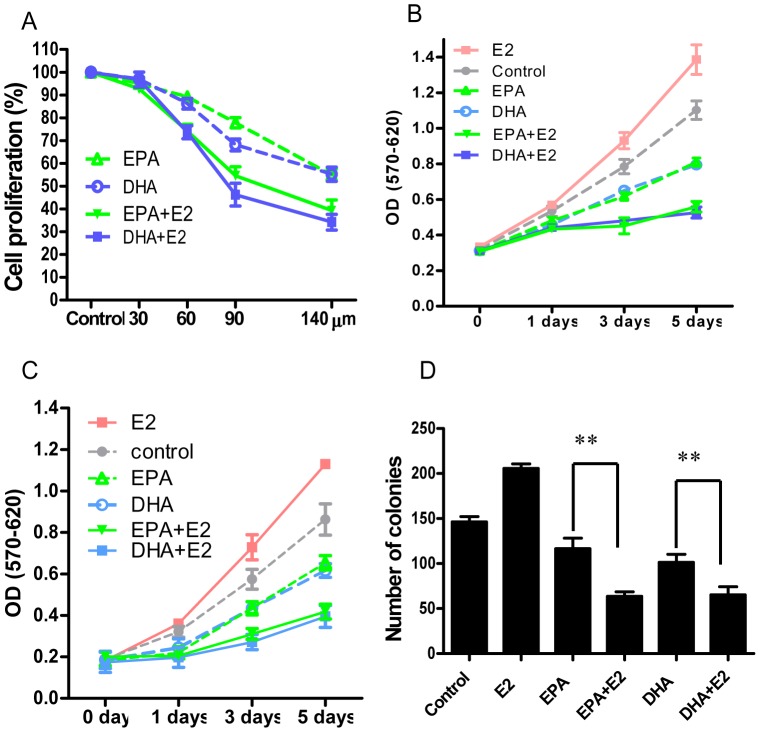
E2 potentiates the inhibiting effect of n-3 PUFAs on BCa cell growth.
A, Dose response of DHA or EPA in MCF-7 cells with or without E2. The cells were treated with indicated concentrations of n-3 PUFAs for 72 hours ± E2 and cell growth was evaluated by MTT assay (see Material and Methods). Data were normalized to the percent of cell growth in control wells. (n = 5). B, Time course for n-3 PUFAs effects in MCF-7 cells. MCF-7 cells were pretreated with 90 µM DHA or EPA with or without 10 nM E2 for different time points (as indicated). Cell growth was measured with the MTT assay (n = 5). C, Time course for n-3 PUFAs effects in T47D cells. T47D cells were treated and followed with MTT assay as the same in Figure 1 B. (n = 4). D, Quantitated data from Anchorage-Independent Growth Assay (see Methods, n = 3). **p<0.001.